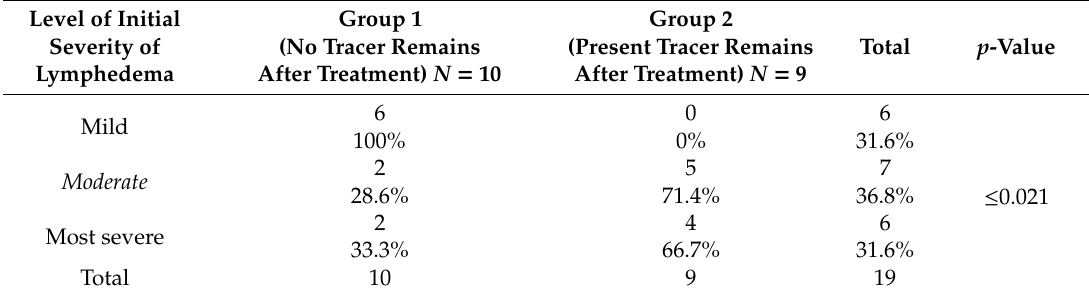
Table 2. Relationship in absolute frequencies and percentages, between the level of initial severity of the lymphedema and the visibility of the ICG